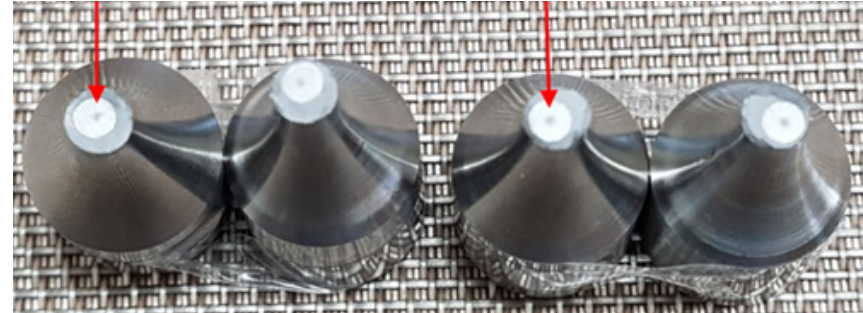
Figure 19. Fatigue fracture of material sample C.